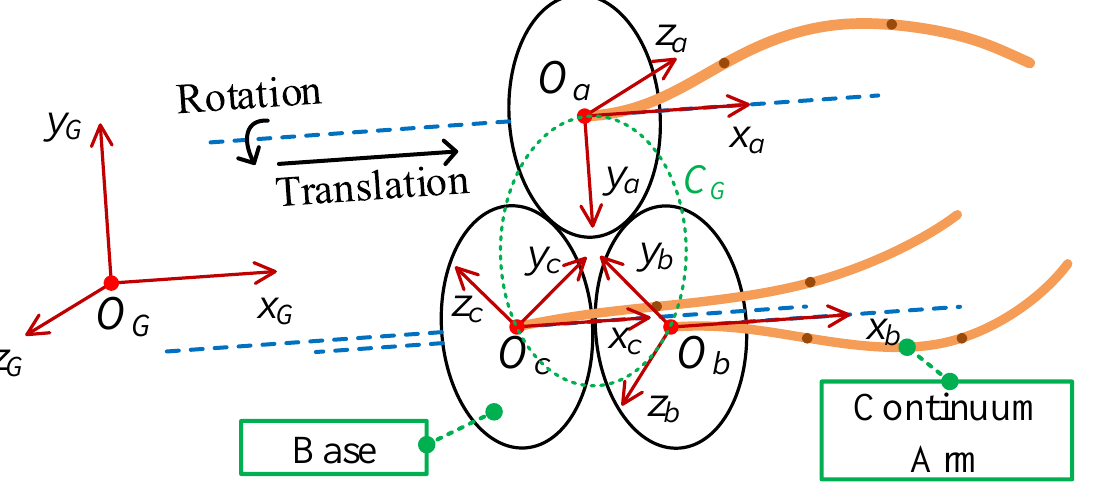
Figure 4. Coordinate system relationship of the space robot. Then the local coordinate system on each continuum arm will be established. Sup- posing the number of the section of each arm is q , then the local coordinate system R i { O i , x i , y i , z i } (0 ≤ i ≤ q ) is shown in Figure 5. Each section of the arm is assumed to be a constant curvature curve [28,29]. The are six DOFs for each arm.